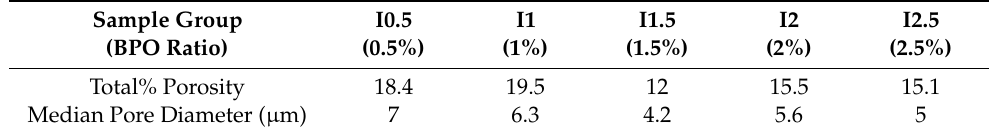
Table 6. Porosity of PMMA bone cement with different initiator ratios.